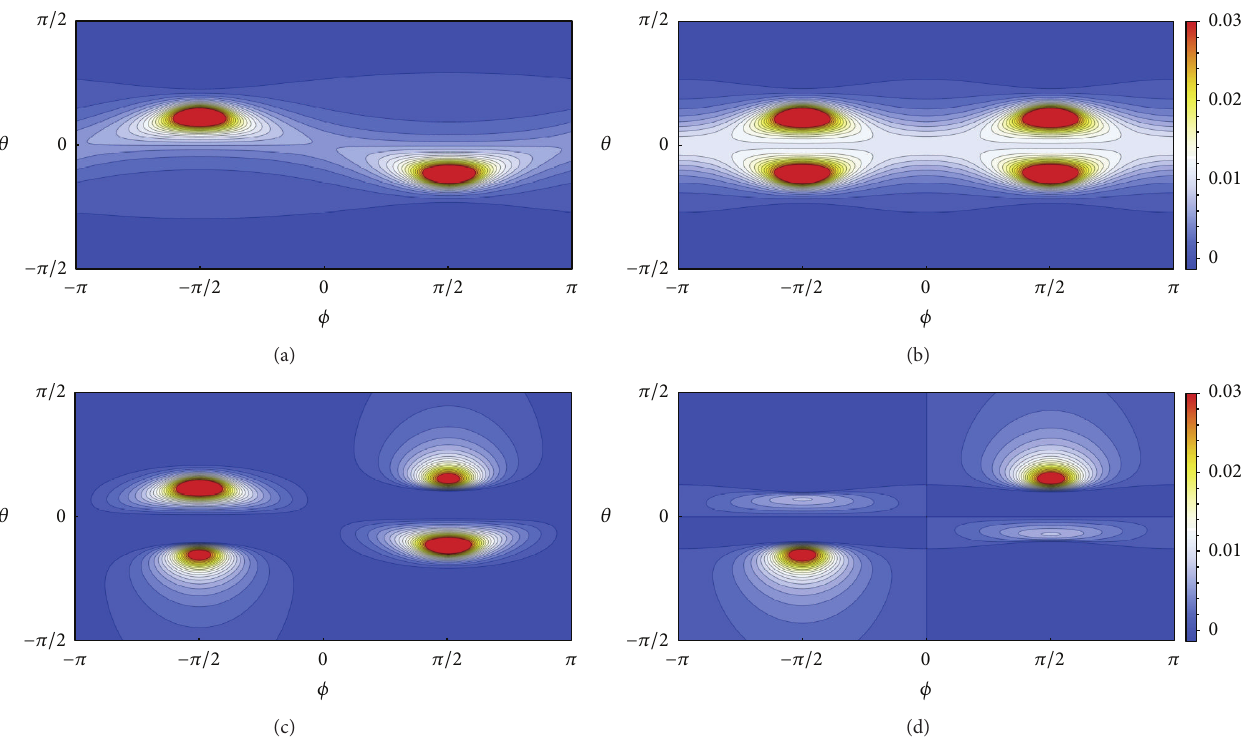
Figure 2: The surface electric potential as a result of the activation of (a) a single dipole, (b) two parallel dipoles, (c) two perpendicular dipoles, and (d) two antiparallel dipoles in close